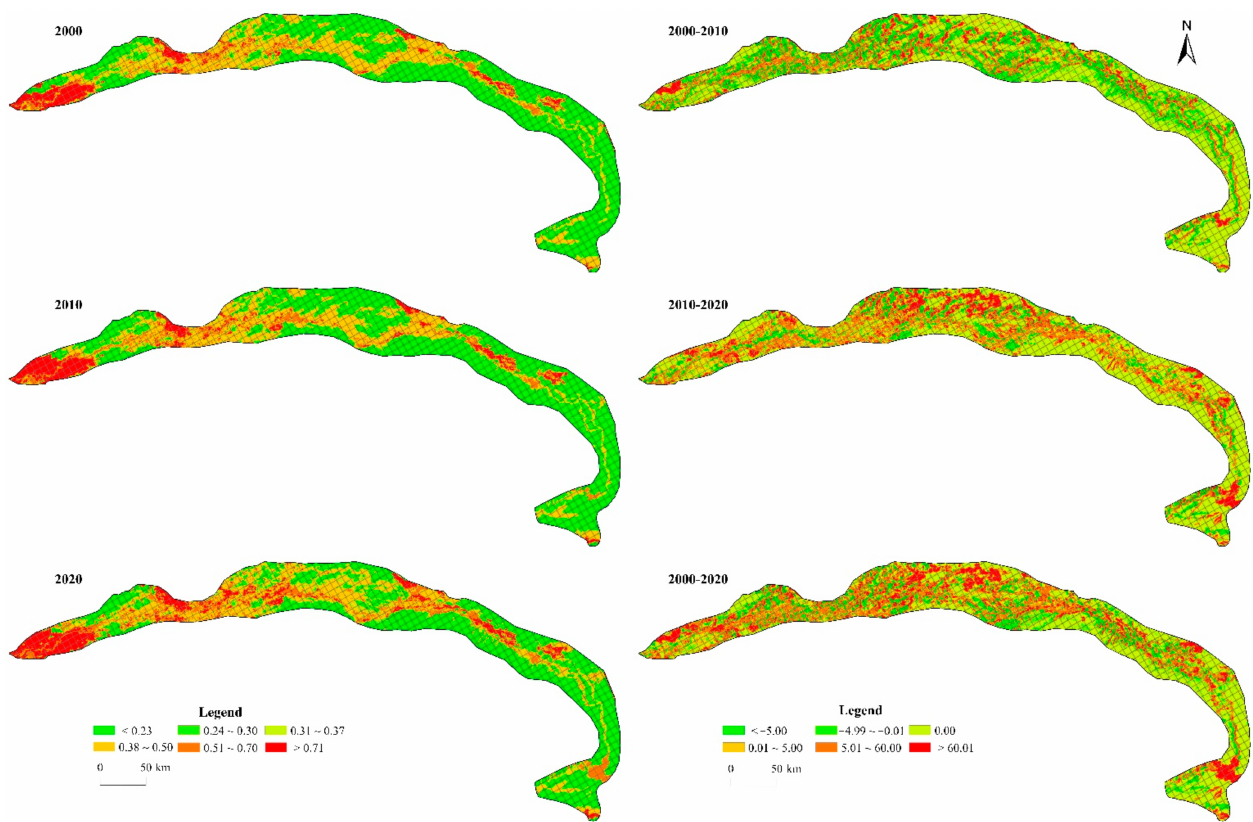
Figure 2. The spatial distribution and variation in the disturbance index of human activities in relation to the main stream of the Tarim